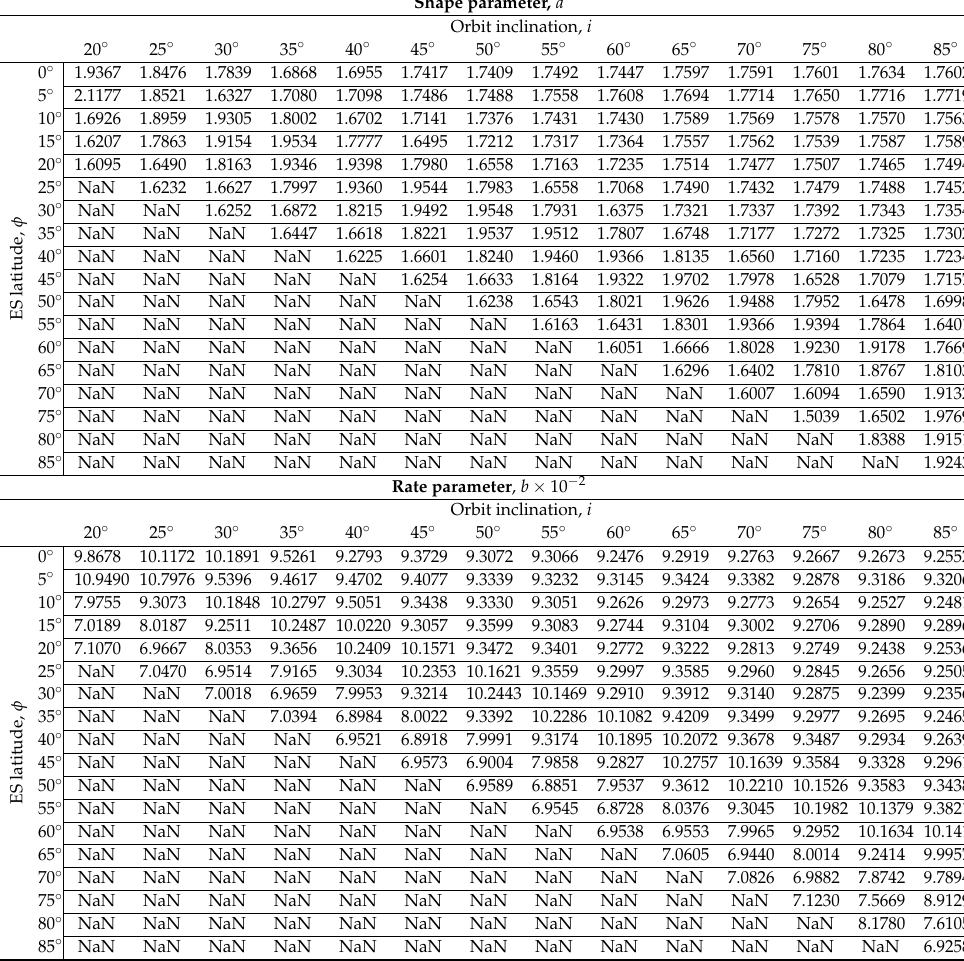
Table A2. Shape, a , and rate, b parameter for f Θ ( θ ) and F Θ ( θ ) for h k = 1200 km.